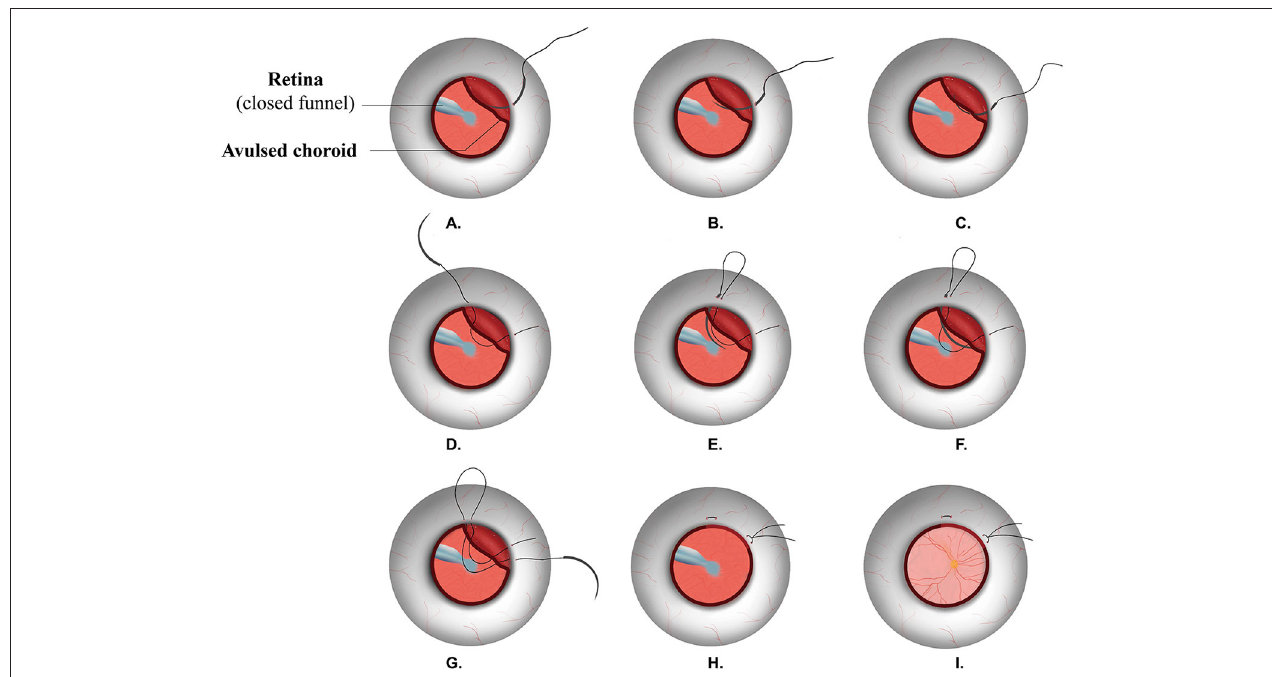
FIGURE 1 | Surgical procedures of TSS. TSS: trans-scleral mattress suturing. A long-curved needle with a 10-0 polypropylene suture (A) was inserted at the sclera 6mm posterior to the limbus, (B,C) passed through the avulsed choroid, (D) exited from the sclera, (E) a U-turn was made, and the needle was reinserted near the exit site; (F,G) the suturing maneuver was repeated, passing through near the insertion site, (H) a knot was tied, (I) a retinal funnel was unfolded, and retina was